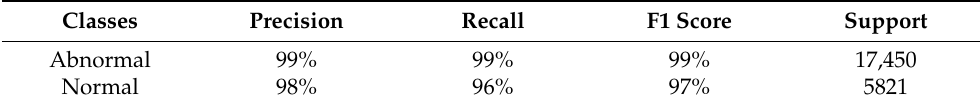
Table 6. Class wise performance evaluation of the tab transformer for binary classification.